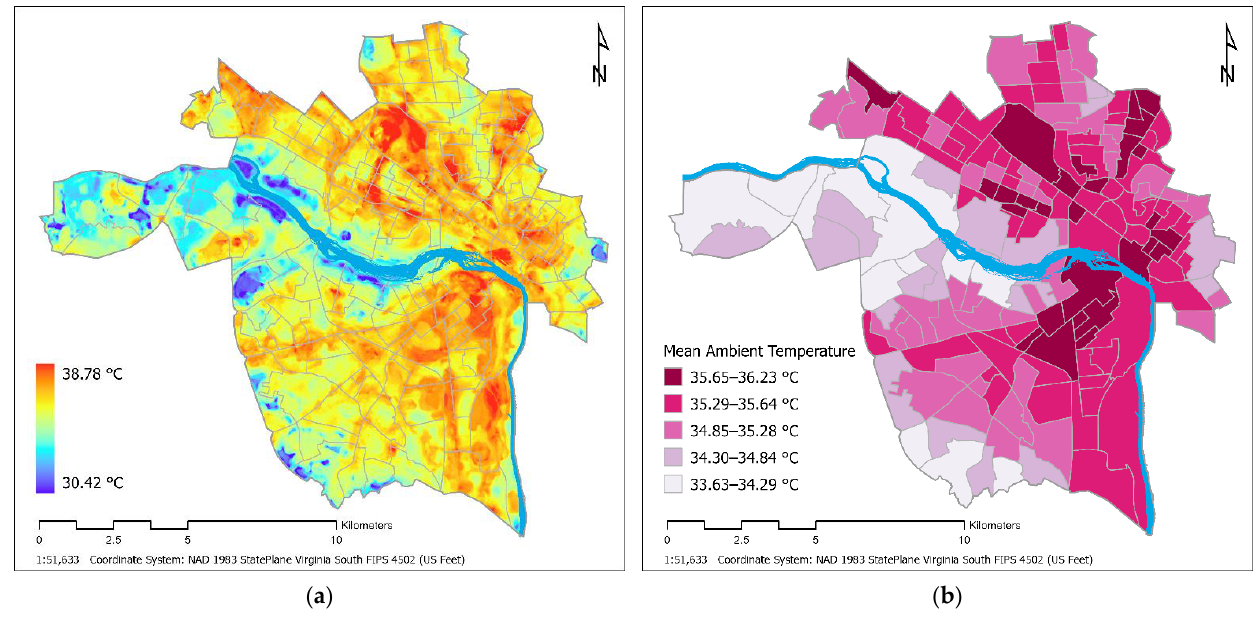
Figure 2. ( a ) Ambient temperatures of Richmond, Virginia. (Data source: ground temperature measurements were collected through vehicular traverses at 3:00 p.m. on 13 July 2017 and integrated with the Sentinel-2 satellite data to predict the city-wide ambient temperatures [37]); ( b ) mean ambient temperature at the Block Group level.